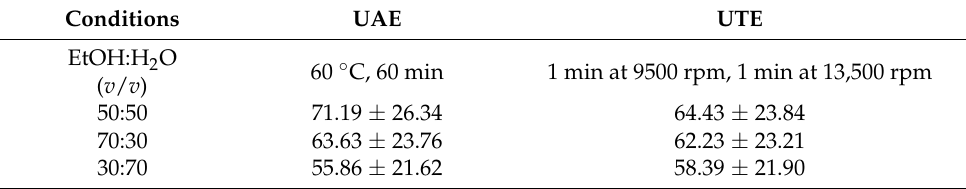
Figure 4. The observed chromatogram and spectrum of phloridzin in standard solution (3 µg/mL) ( a ) and UAE extract ( b ) with Q-TOF-LC/MS. Table 1. Phloridzin content ( µ g/g fresh AP, mean ± SD n = 2) obtained with UAE and